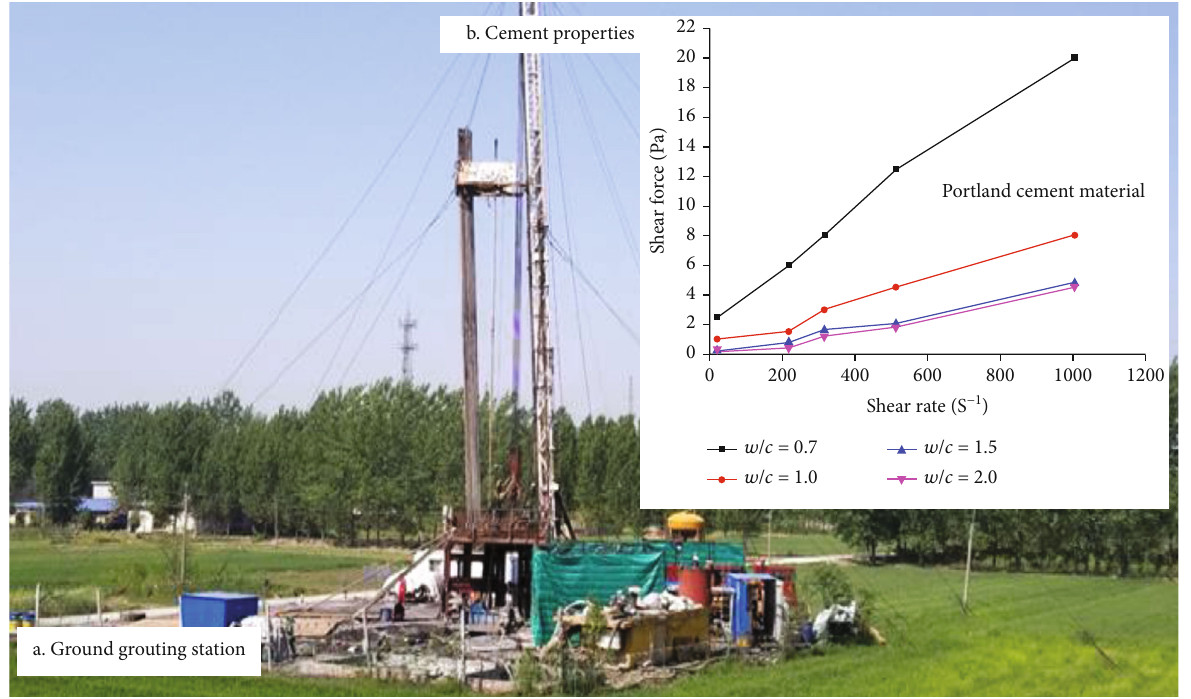
Figure 3: Grouting station and material